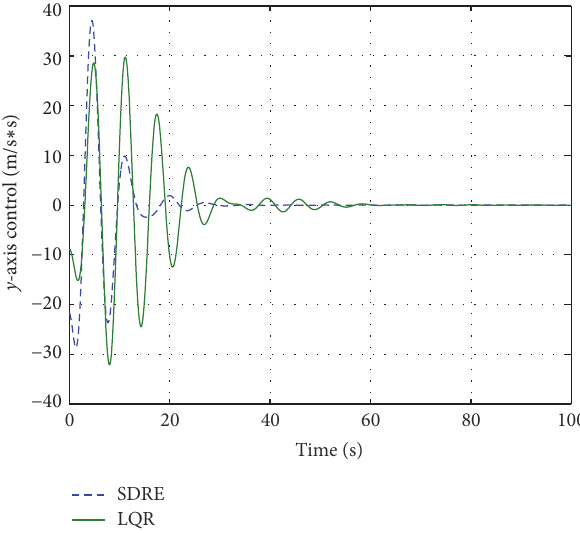
Figure 11: 𝑍 axis velocity error variation curve.